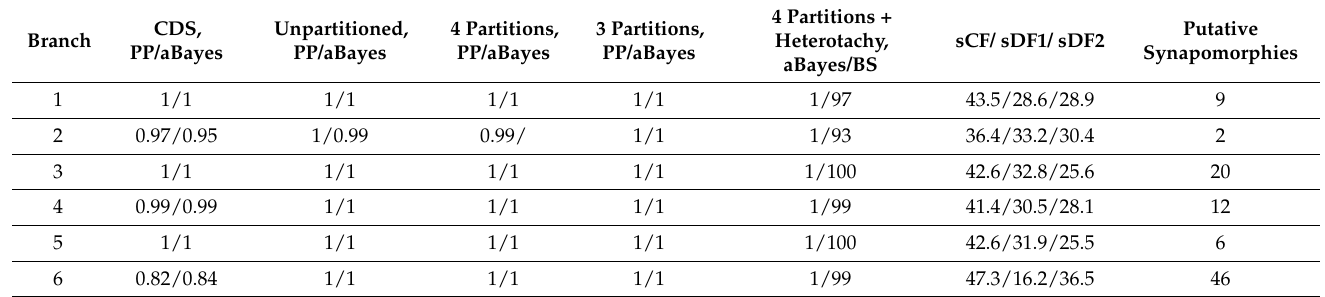
Table 2. Support for branches 1–6 gained in phylogenetic analyses of CDS and full data matrices in unpartitioned and partitioned phylogenetic analyses. PP = posterior probability, aBayes = “ a la Bayes” support, BS = nonparametric bootstrap support, sCF/sDF = site concordance/discordance